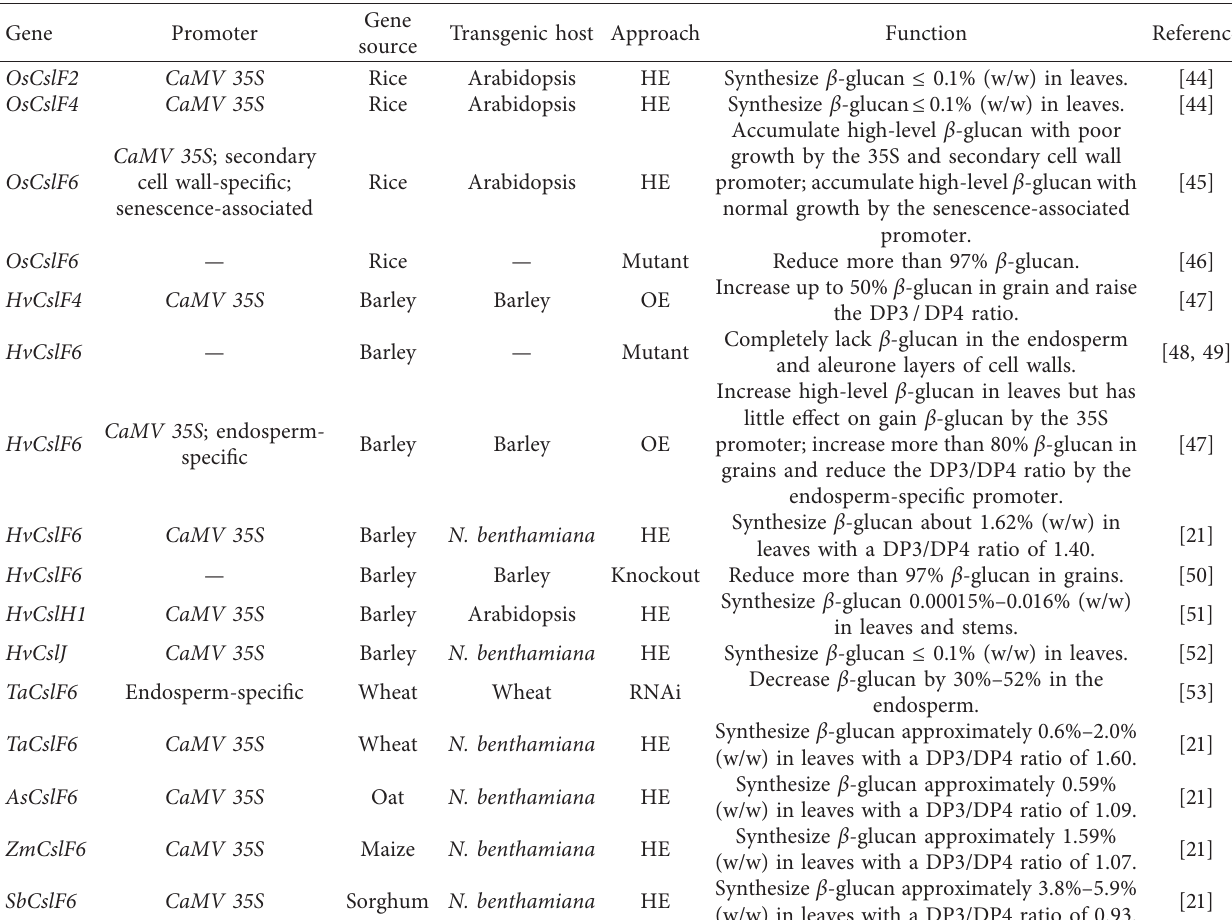
Table 2: List of genes confirmed to function in β -glucan synthesis in cereals.